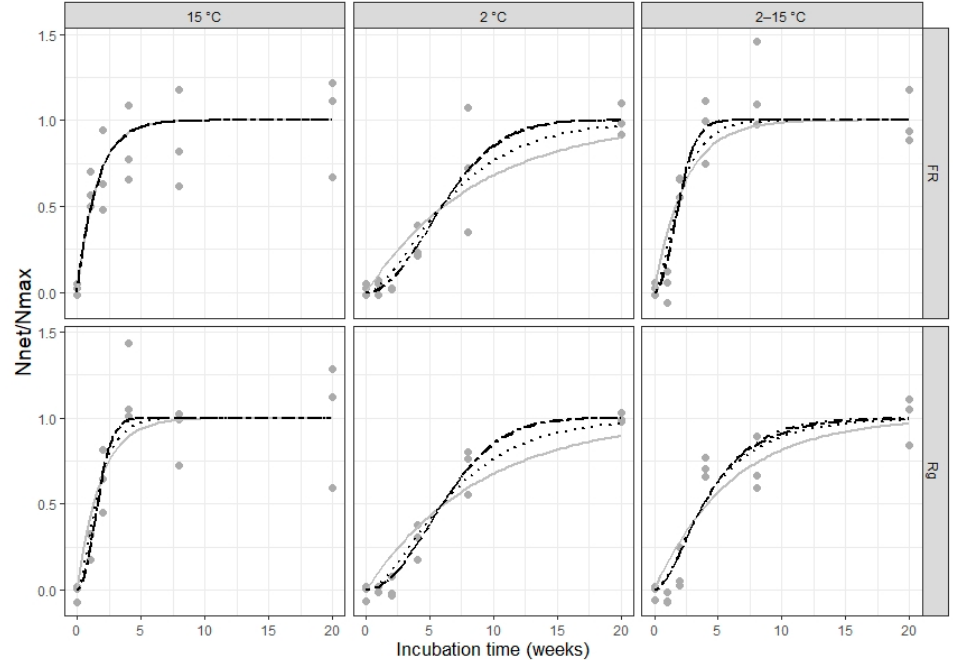
Figure 5. Smoothed curves showing results from nonlinear least-squares regression of different functions to N net data, here normalized to N max for ease of view. The gray dots ( • ) represent the experimental results, and the solid gray lines correspond to fitted values using first-order kinetics (FOK). The black lines represent FOK models modified with a lag term: exponential lag term (dotted), a Gompertz-type equation (dashes), and a Monod-type equation (dot-dash).